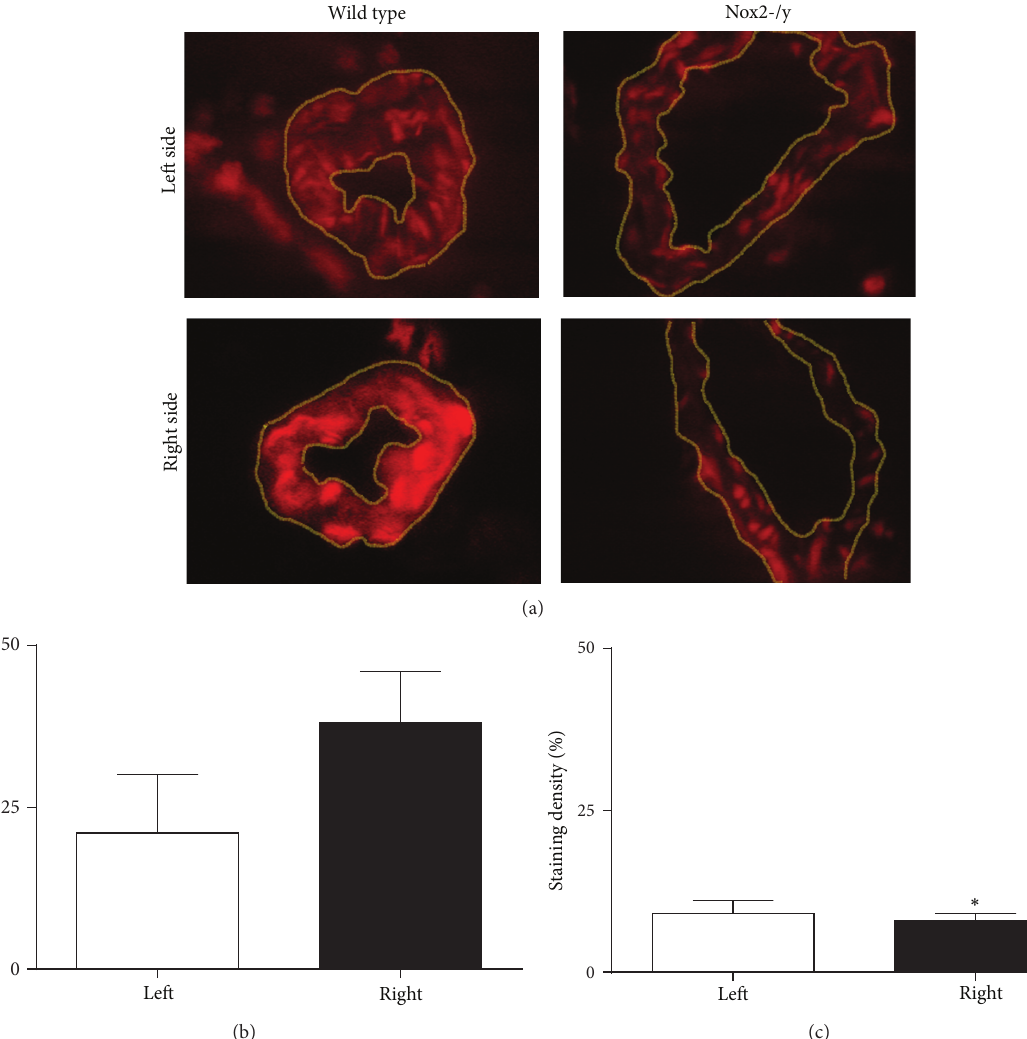
Figure 1: Representative micrographs of superoxide levels determined by hydroethidium fluorescence of WT left-sided, WT right-sided, Nox2-/y left-sided, and Nox2-/y right-sided cerebral arterioles (highlighted in yellow) (a). Graphs showing relative staining density of WT (b) and Nox2-/y mice (c) ( 𝑛 = 8 ). ∗ 𝑃 < 0.05 versus WT right-sided cerebral